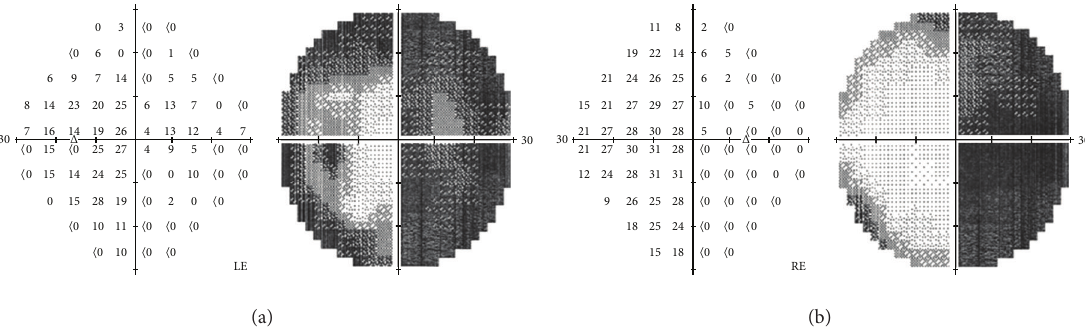
Figure 1: Visual field testing Humphrey 30-2. Left eye (LE) and right eye (RE), showing a right homonymous hemianopia with constriction of the remaining left hemifield on the LE.